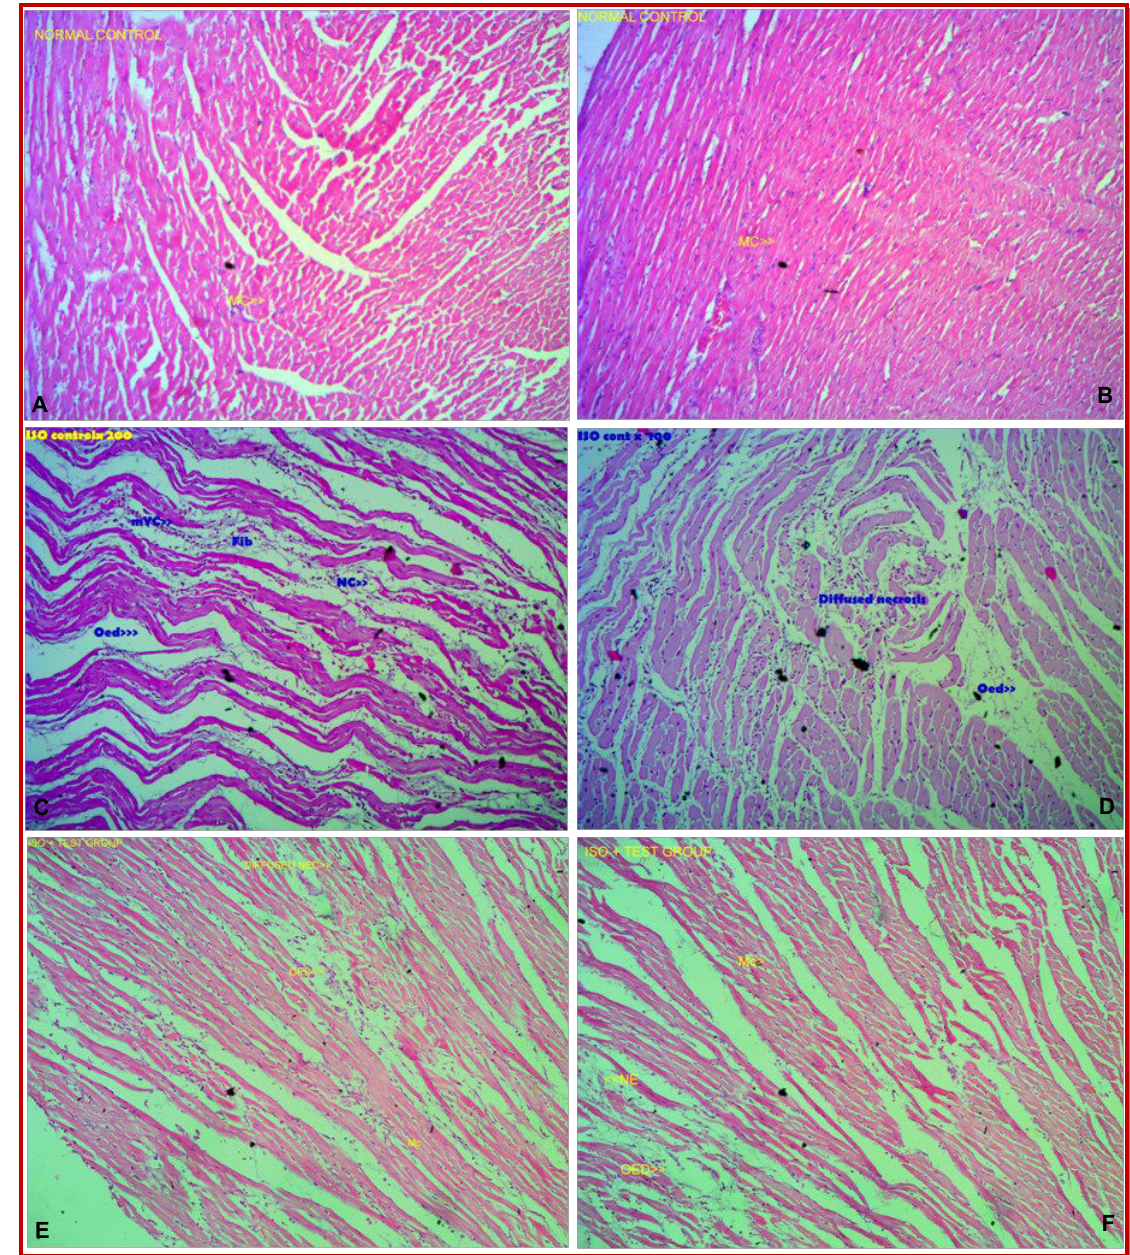
Figure 1 (A, B): Photomicrographs of representative heart sections from normal control group treated with gum acacia shows nor- mal cytoarchitecture. Myocardium (MC); (C, D): Photomicrographs of representative heart sections from isoprenaline group shows moderate to severe necrotic lesions (NC), myocarditis interstitial edema (Oed), focal cell infiltration (Fc), hemorrhages (Hg) and fatty changes were observed; (E, F): Photomicrographs of representative heart sections from test drug + Isoprenaline injected rats shows mild moderate necrotic lesions (NEC) and myocardial interstitial edema (Oed). The test drug showed a maximum pro- tective effect by reduced histological